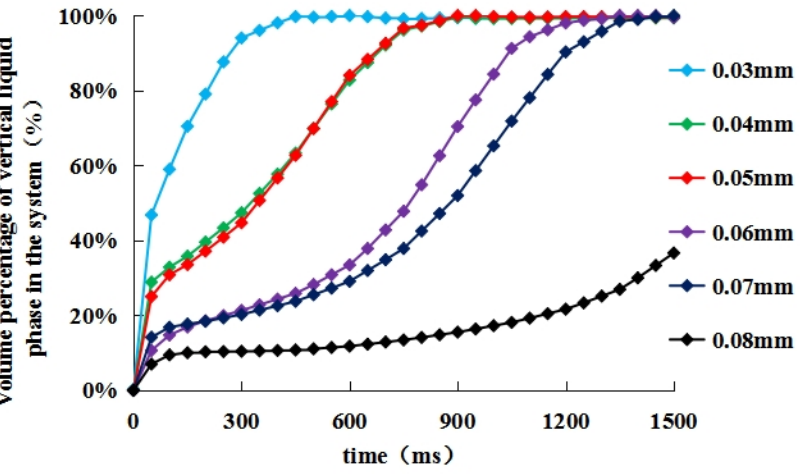
Figure 7. The volume fraction of oil phase at the vertical position of two oil droplets at different distances.